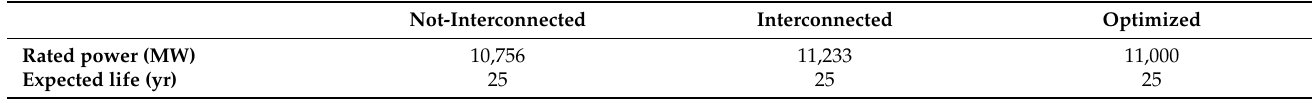
Table 11. PV system